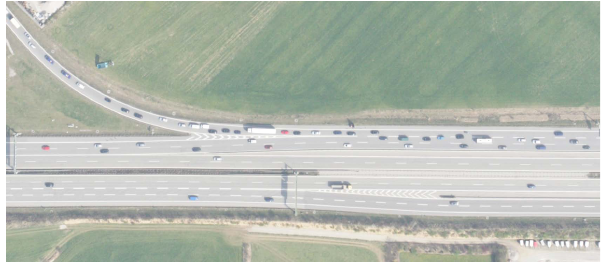
Figure 5: Original 3K image sample